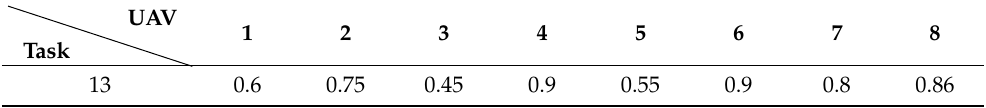
Table 11. UAV damage capability information.